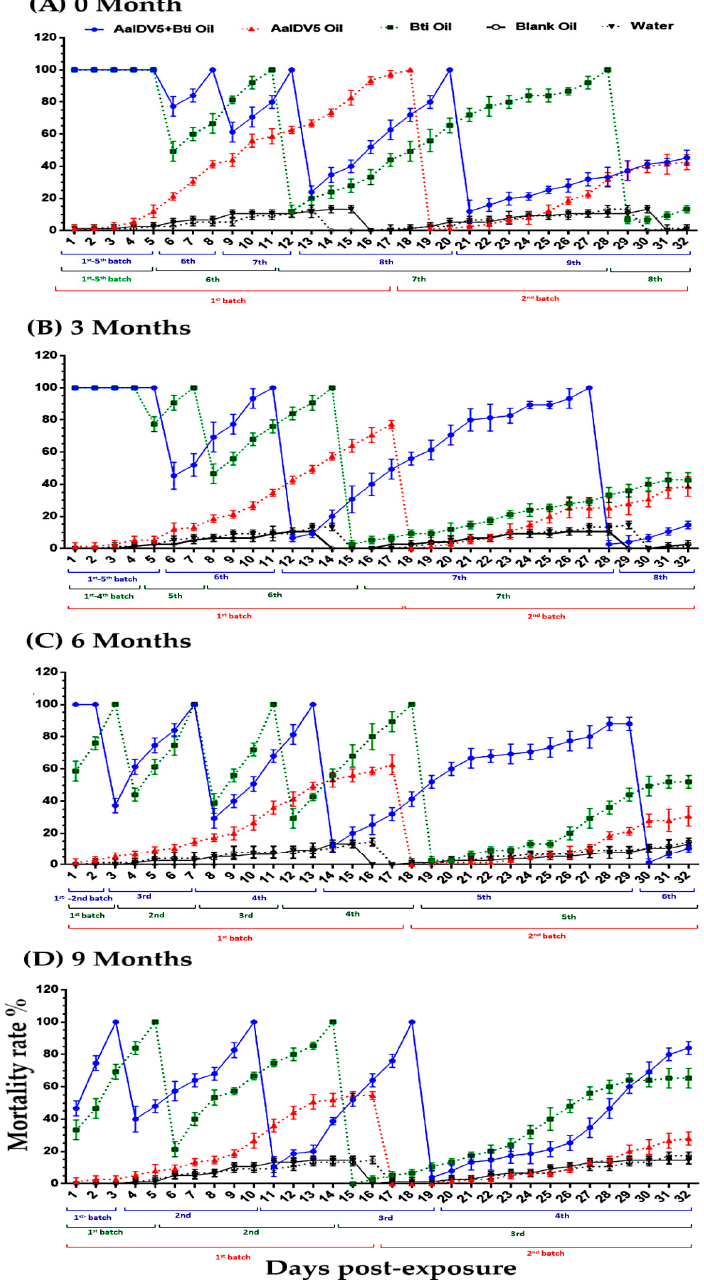
Figure 3. Comparative bioassay of oil suspensions over different storage times (0–9 months) against Ae. albopictus larvae in the open-field condition. ( A ) Efficacy of oil suspensions on first instar larvae at 0 months, ( B ) 3 months, ( C ) 6 months, and ( D ) 9 months of storage. The bars indicate SDs from three independent (biological) replicates, where each batch contains 25